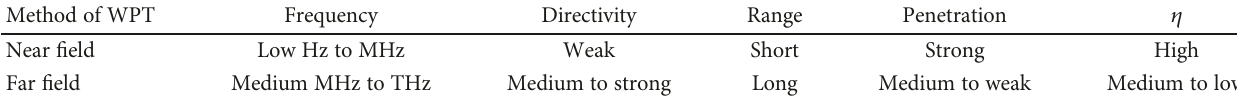
Table 1: Comparison of WPT methods.